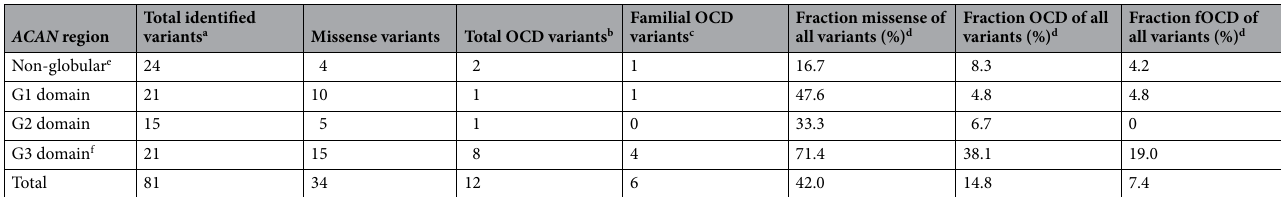
Table 3. Distribution of variants in ACAN regions (updated December 2021). Note over-representation of familial and sporadic OCD variants in G3 domain. a Including only variants with evidence for heredity and segregating with disease (see Supplemental Table 1 for additional variants). b ACAN variants where proband presents with OCD. c ACAN variants linked to hereditary OCD, i.e. found in proband and other variant- carrying family members. d Percent of total variants in the region. e Including intron 1, signal peptide, IGD (interglobular domain) and the KS and CS attachment regions. f Of the G3 variants, 19 (including all fOCD and OCD variants) locate in the C-type lectin